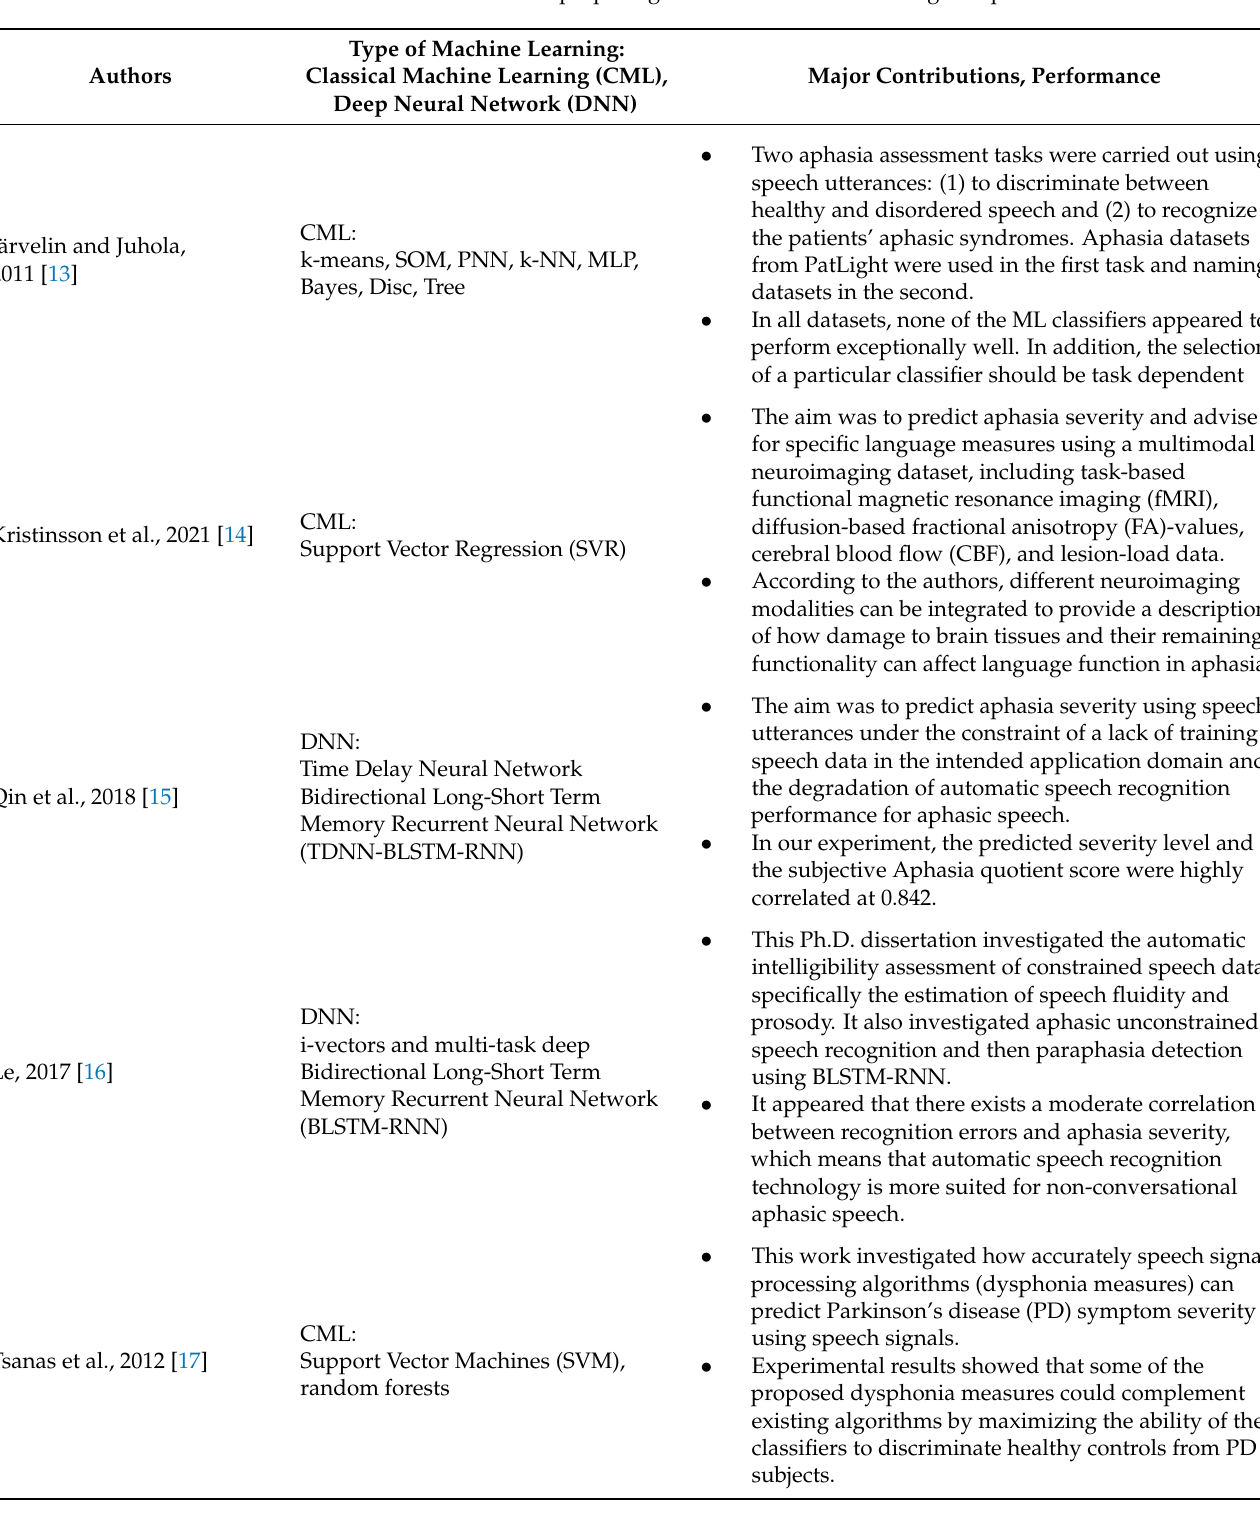
Table 1. Review of works proposing the use of machine learning for aphasia